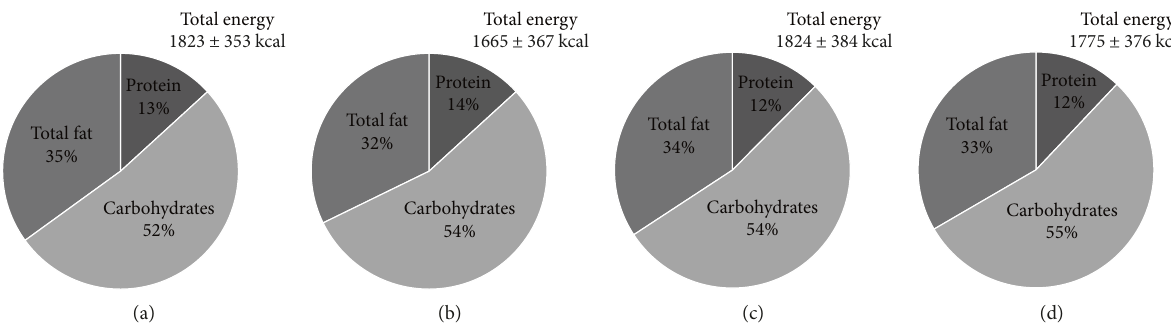
Figure 5: Changes in dietary pro fi le after intervention. Showing dietary pro fi le. (a) Preintervention in the intervention group ( n , 38). (b) Postintervention in the intervention group ( n , 25). (c) Preintervention in the control group ( n , 38). (d) Postintervention in the control group ( n ,